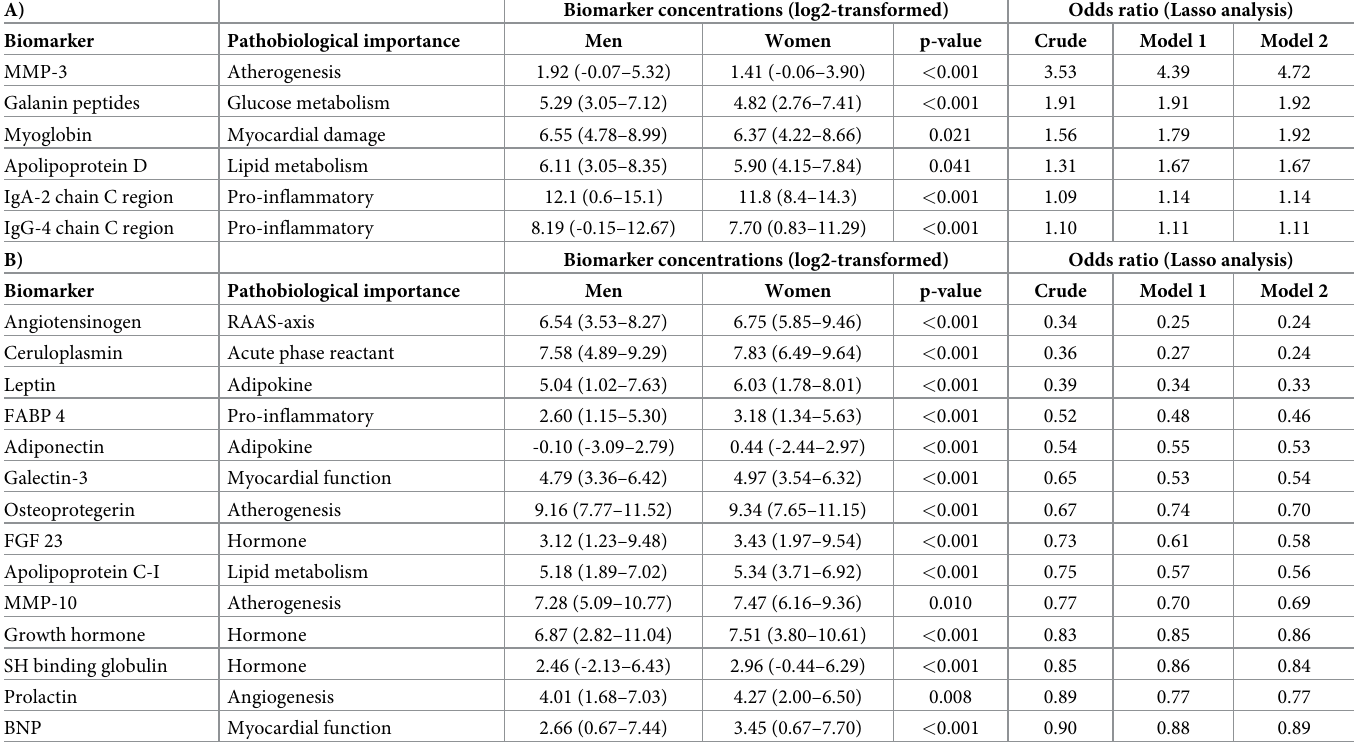
Table 2. Biomarker concentrations and results from the Lasso analysis. A) Biomarkers with higher concentrations in men; B) Biomarkers with higher concentrations in women.